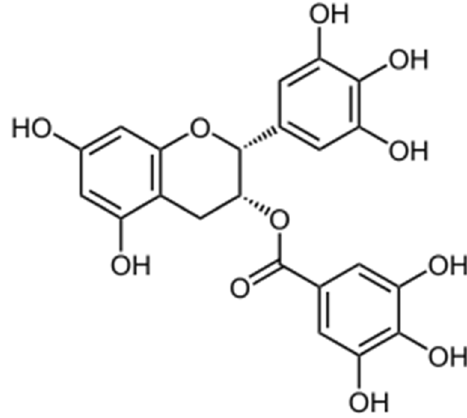
Figure 1. Chemical formula of EGCG [48].